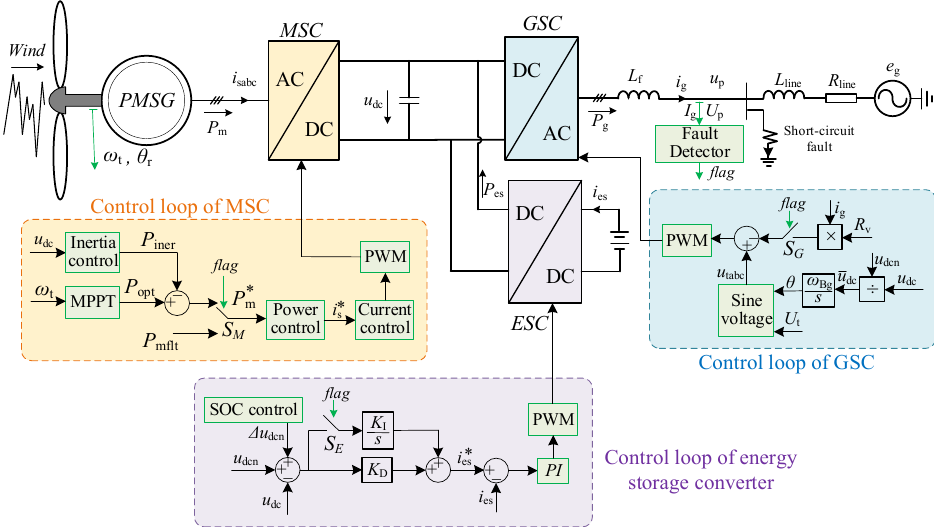
Figure 3. Control structure of the PMSG-based wind turbine with the auxiliary energy storage device.